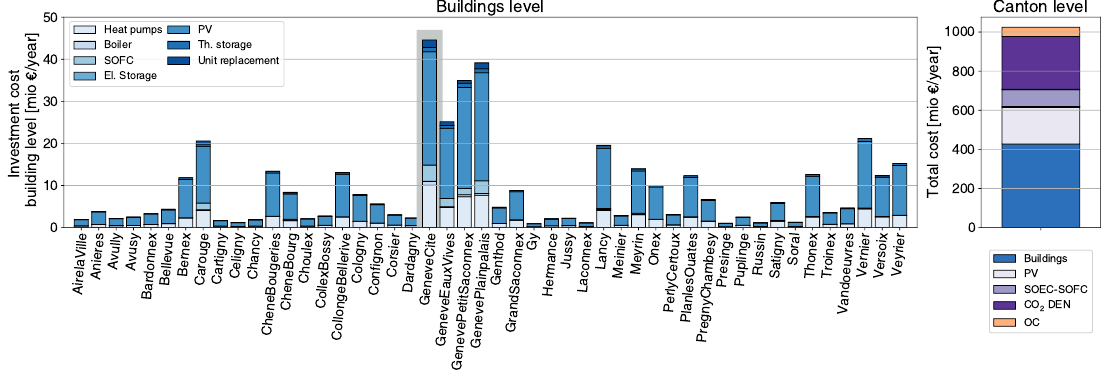
Figure 19. Breakdown of investment and total cost at buildings/canton level.